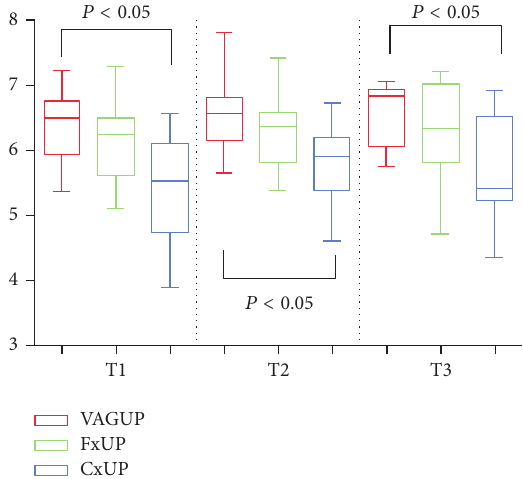
Figure 2: Mean log values (with 95% CI) of U. parvum (UP) during pregnancy for the three sample sites. VAG UP: vaginal Ureaplasma parvum . Fx UP: fornix Ureaplasma parvum . Cx UP: cervical Ure- aplasma parvum . T1: first trimester. T2: second trimester. T3: third trimester.